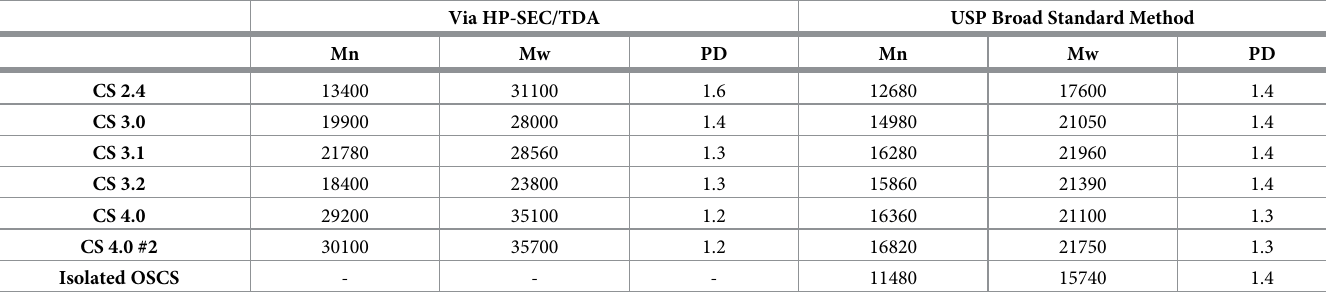
Table 2. Molecular weights of additionally sulfated CSs. Molecular weights have been measured via HP-SEC/